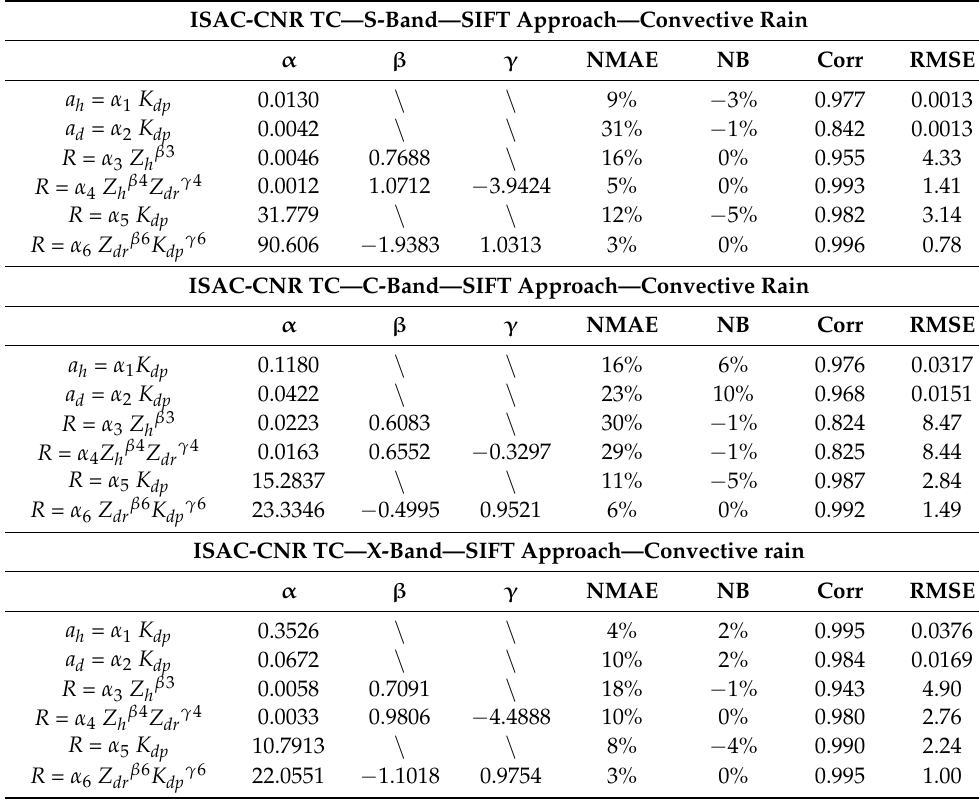
Table 6. As for Table 5, but for convective rain.